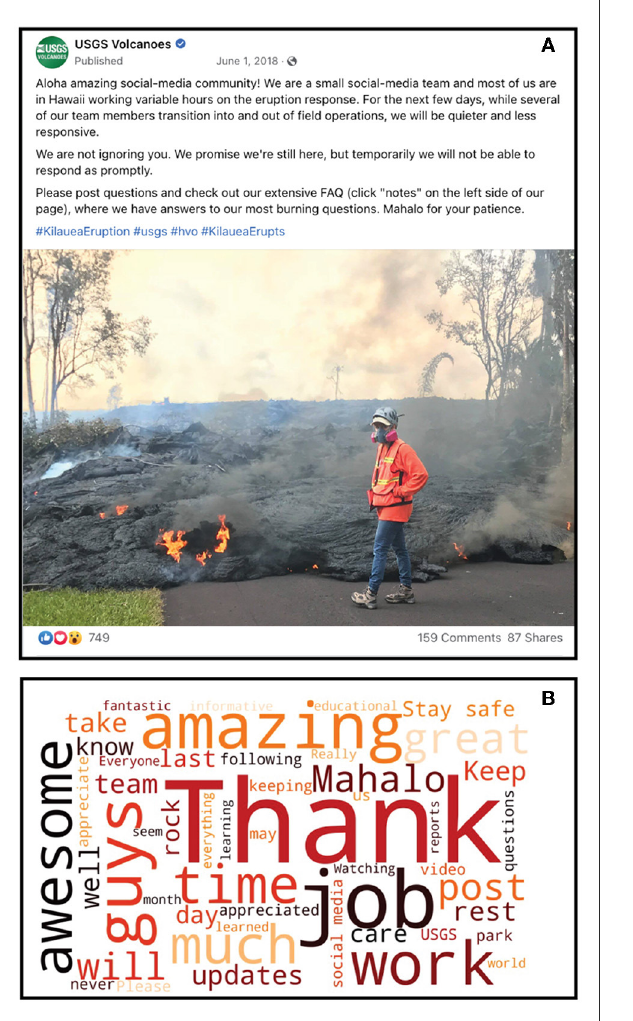
FIGURE5 Specific posts were made during times when the social media team was going to be less able to post content and answer questions than usual (A) . The photo in the post shows Wendy Stovall measuring the exact location of the flow front on a residential road in the Leilani Estates neighborhood. Comments and replies to these posts were overwhelmingly positive and included messages of thanks for staff providing information via social media as well as the people on the ground monitoring the eruption. The word cloud (B) represents the most frequently used words from the 159 comments to the post shown in (A) , which is characteristic of positive-sentiment feedback